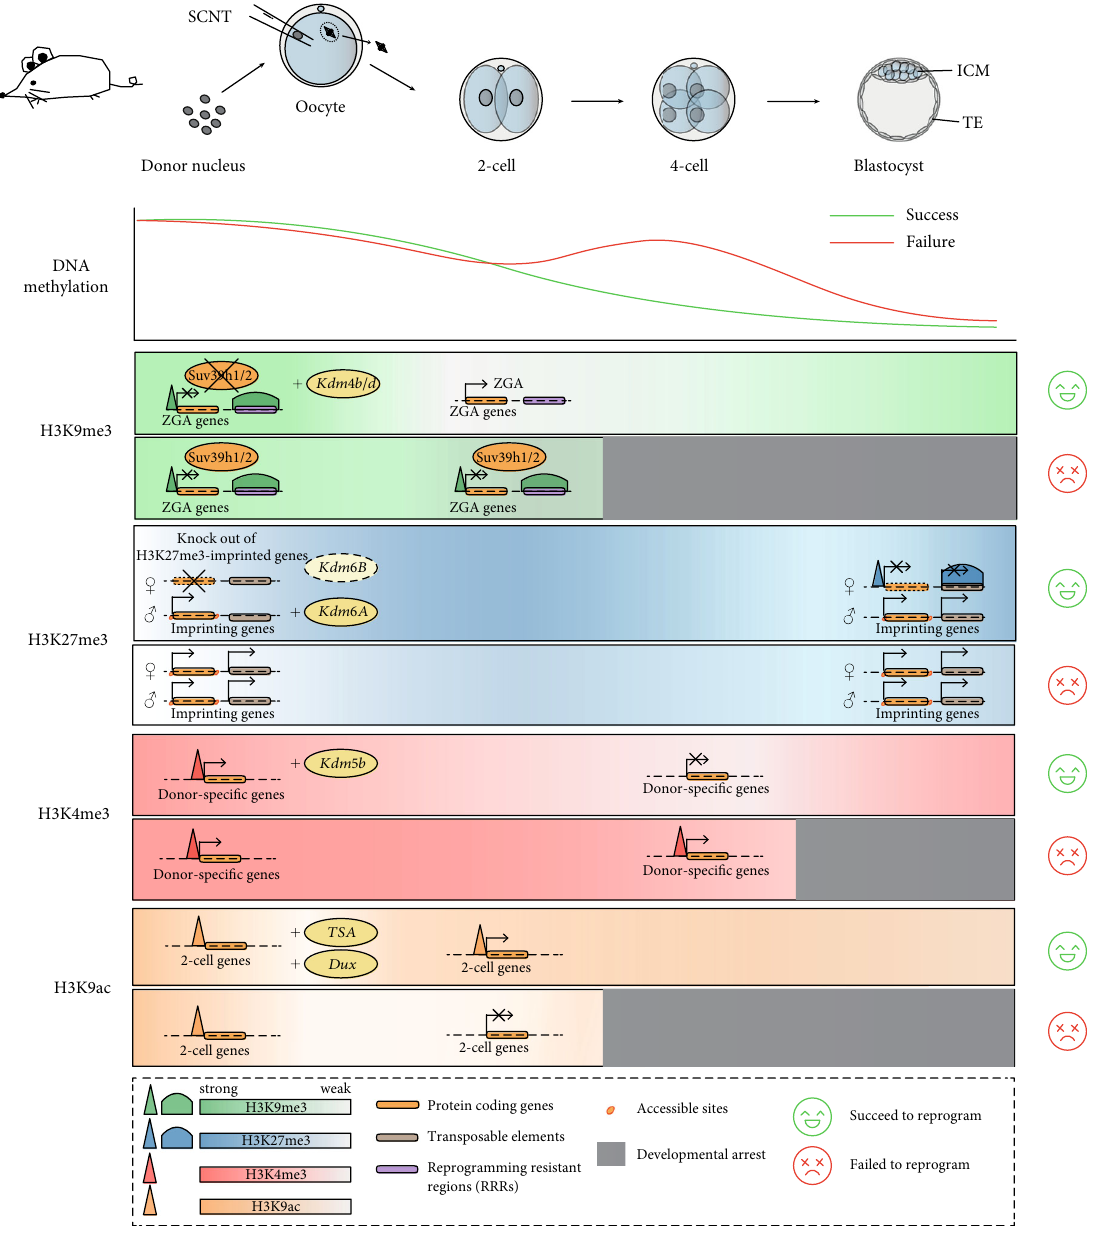
Figure 1: Epigenetic reprogramming of DNA methylation and histone modi fi cations during mouse SCNT embryo development. DNA methylation: somatic donor cells usually possess high DNA methylation levels. After activation, the reconstructed embryos undergo global DNA demethylation although this demethylation has not been completed at the late 1 cell stage of SCNT embryos and requires several rounds of replication delusion. However, there is an aberrant remethylation in arrested 4 cell stage SCNT embryos and reduction of the inappropriate DNA methylation rescued the developmental arrest. H3K9me3 : during SCNT embryo development, some zygotic genome activation (ZGA) genes and reprogramming resistant regions (RRRs) harbor donor cell-inherited H3K9me3 mark, which may be the cause of reprogramming failure. Removal of donor-inherited H3K9me3 either by ectopic expressing Kdm4b/d (H3K9me3-speci fi c demethylases) or knockdown of Suv39h1/2 (H3K9 methyltransferases) can help the embryo overcoming the reprogramming defects. H3K27me3 : loss of H3K27me3-mediated imprinting leads to defects of extraembryonic tissues of SCNT embryos, such as large placenta phenotype. Although overexpression of H3K27me3-speci fi c demethylase KDM6A elevated blastocyst developmental rate but not full-term development, both knock out of H3K27me3-imprinted genes and knockdown KDM6B can help SCNT embryos undergo successful reprogramming. H3K4me3 : donor-inherited H3K4me3 is de fi ned as an epigenetic barrier of SCNT reprogramming. H3K4me3 demethylation by Kdm5b overexpression is an important step to overcome reprogramming failure. H3K9ac : during SCNT development, aberrant H3K9ac regions impair ZGA. TSA treatment and Dux overexpression can correct the aberrant H3K9ac signal and help the embryos achieve successful